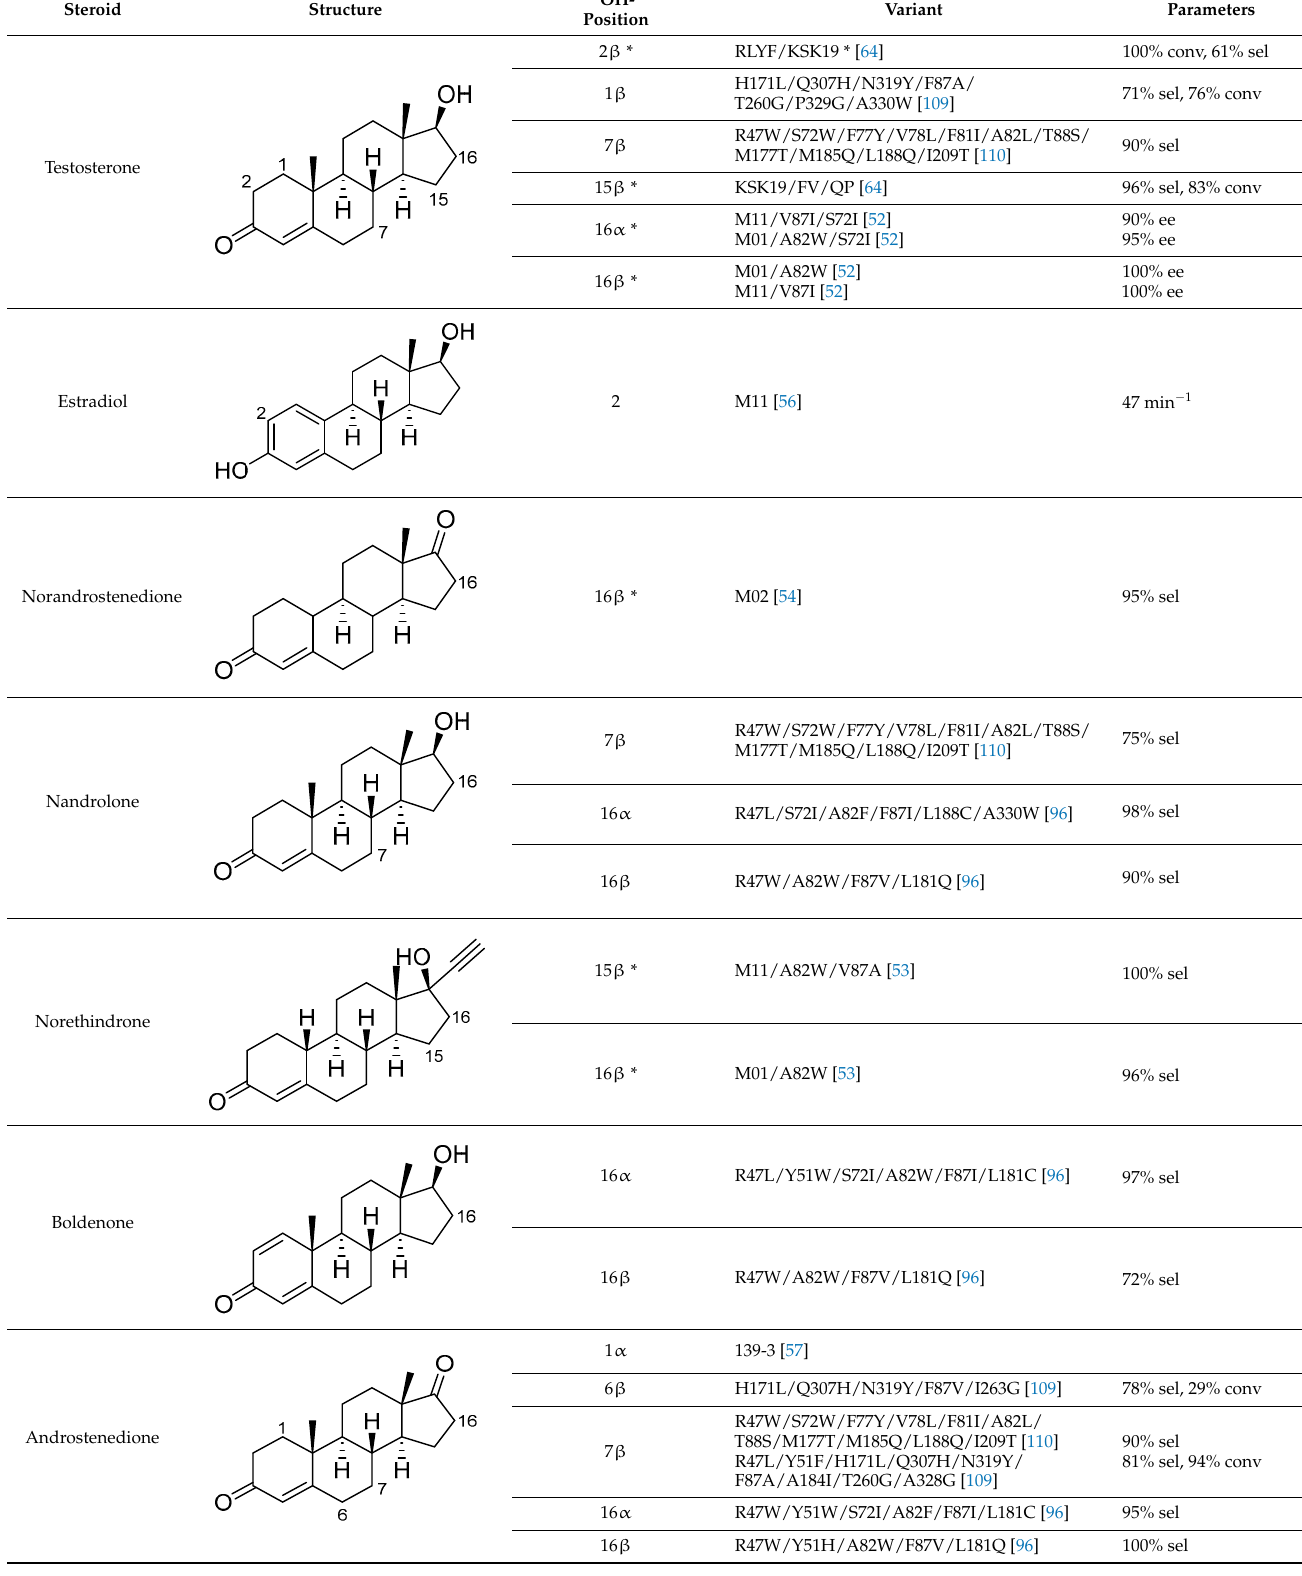
Table 2. BM3-mediated steroid metabolism. Only sites of modification are identified. * Indicates human CYP3A metabolite. Conv, conversion; sel, selectivity; ee, enantiomeric excess.